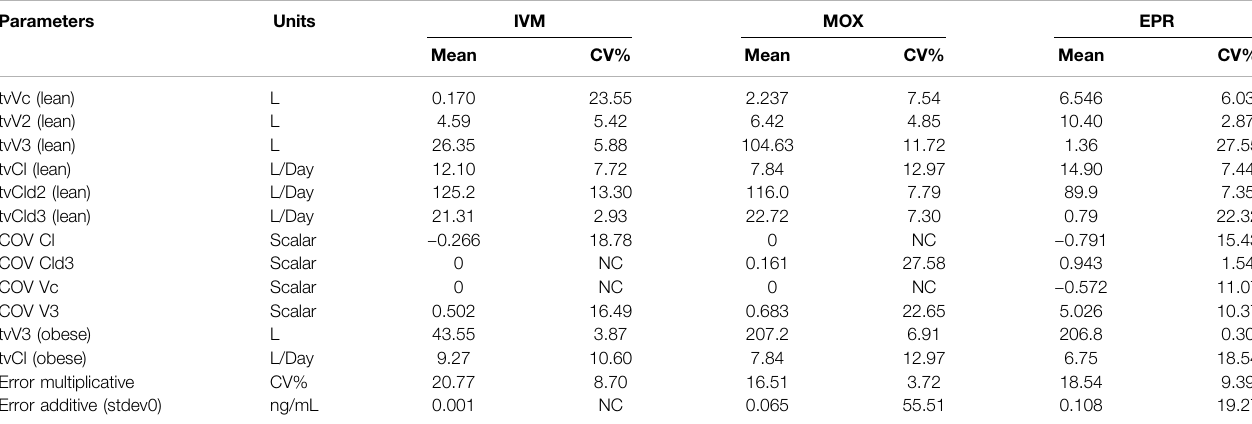
TABLE 2 | Population primary parameters as obtained with a 3-compartment model with covariate (COV) (lean vs. obese); estimates bootstrap (mean and CV%).